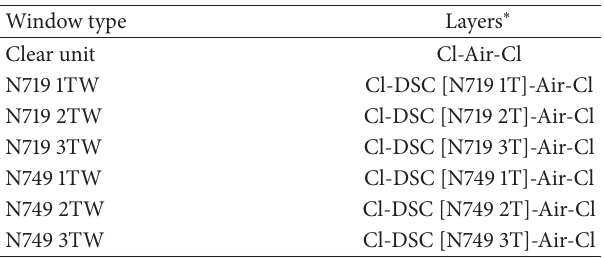
Table 3: Composition of window units.